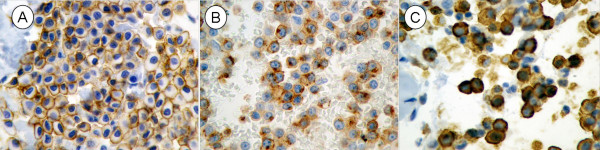
Immunohistochemical staining patterns of canine cutaneous MCTs staining with anti-KIT antibodies. A. KIT staining pattern 1: peri-membrane KIT protein localization; B. KIT staining pattern 2: focal or stippled cytoplasmic KIT protein localization; C. KIT staining pattern 3: Diffuse cytoplasmic KIT localization. Canine MCTs with KIT staining patterns 2 and 3 that lacked ITD c-KIT mutations were screened for mutations in c-KIT exon 17. B and C show MCTs with aberrant KIT localization that lack ITD c-KIT mutations.